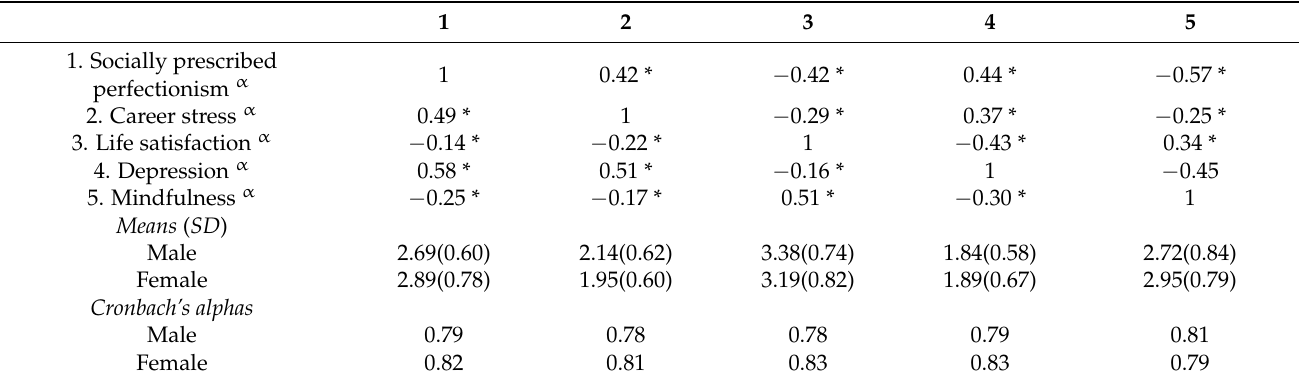
Table 1. Correlations and descriptive statistics for study